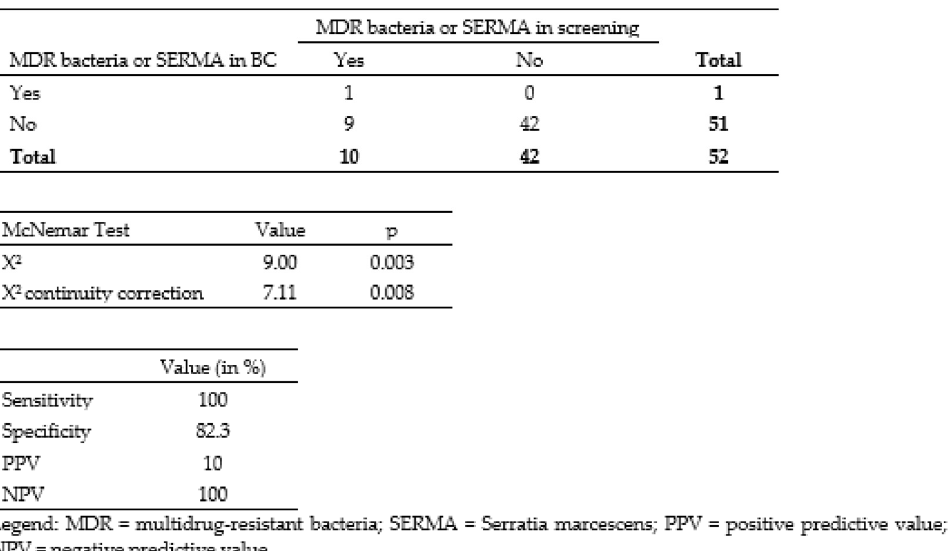
Figure 3. Contingency table with number of patients with MDR bacteria or SERMA in screening and in BC.